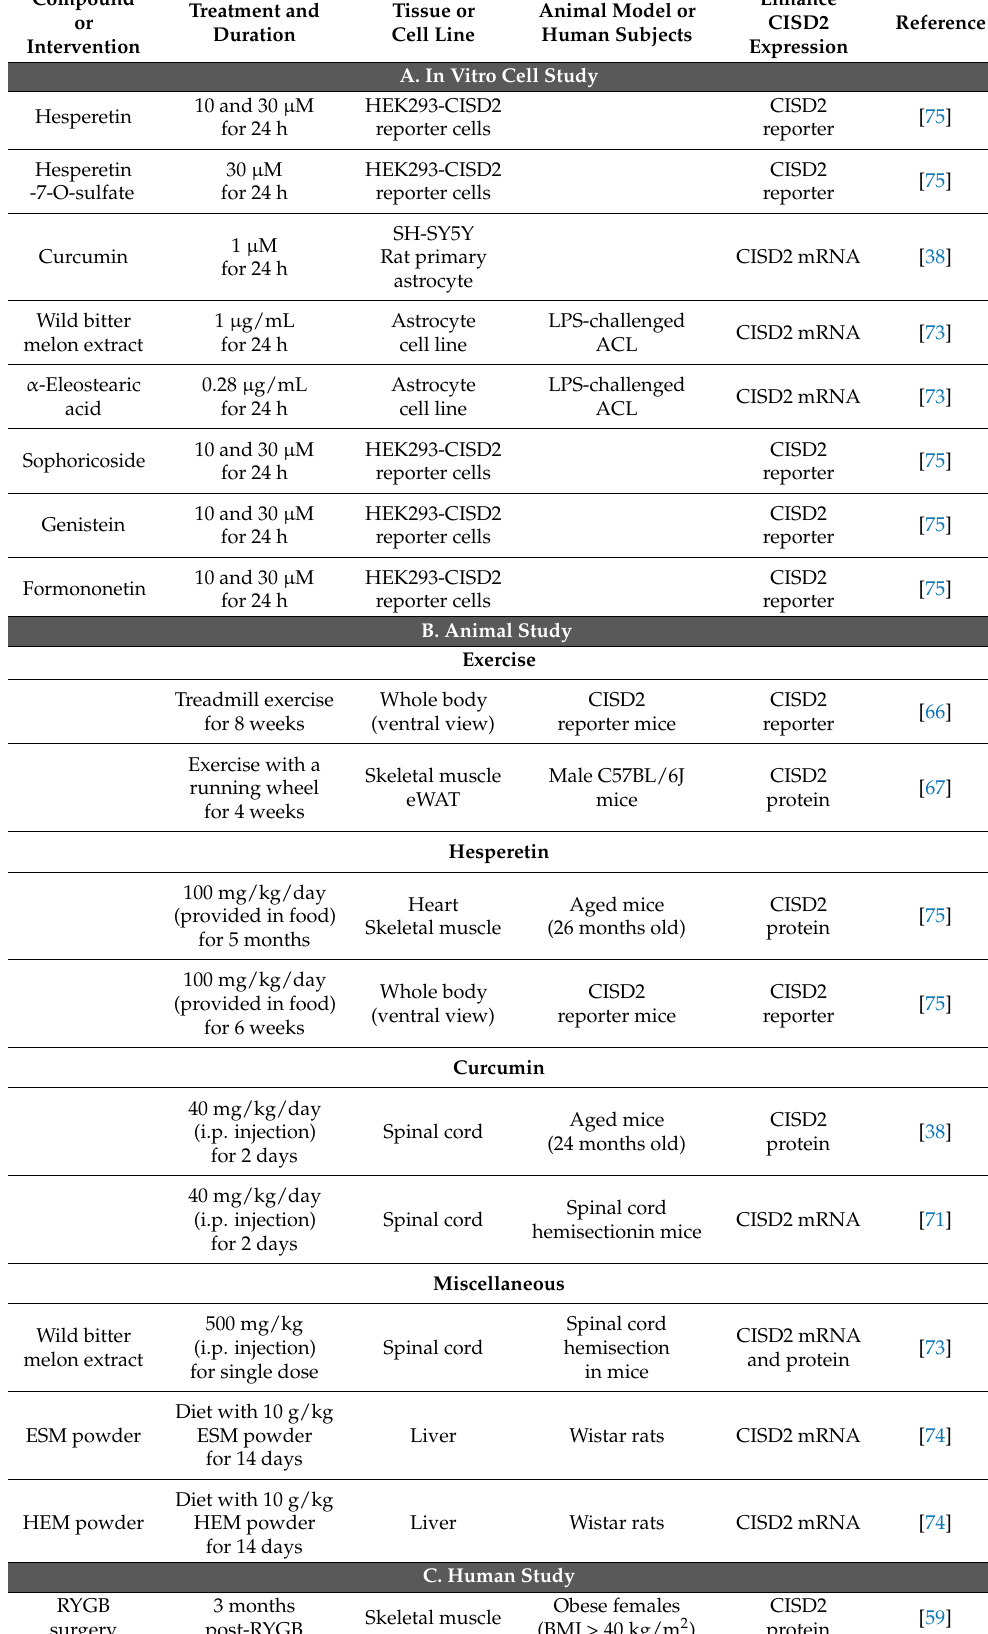
Table 1. Regimens or treatments that enhance CISD2 gene